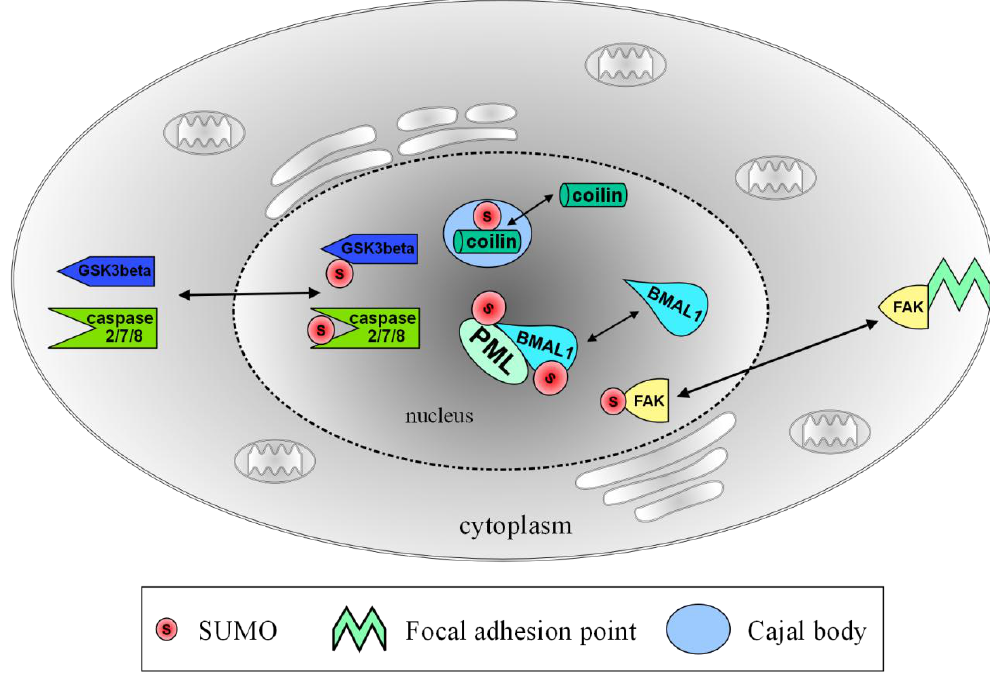
Figure 1. Translocation of nuclear and nucleo-cytoplasmic proteins SUMOylation. In the nucleus, SUMO modification leads to the formation of Cajal bodies, which are positive for coilin and SUMO. Other SUMO related nuclear structures are PML bodies, which contain SUMOylated PML and SUMOylated BMAL1. Caspases